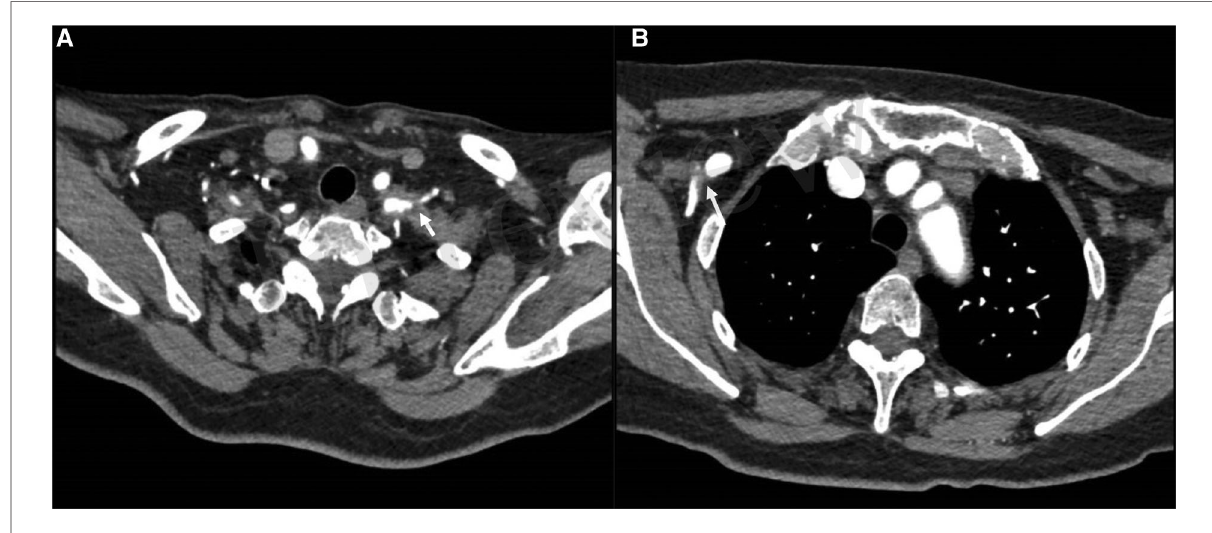
FIGURE 1 Preoperative CT scan revealing soft tissue compression of the right axillary artery ( B ) and the left subclavian and axillary artery ( A ).